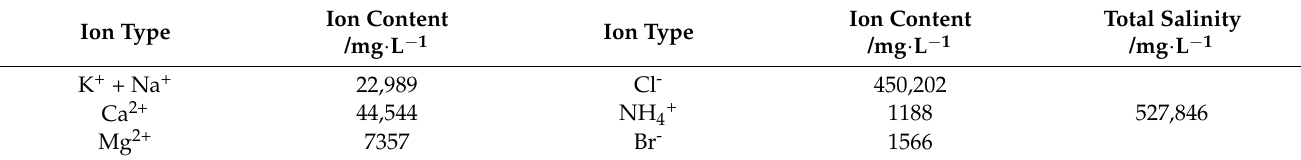
Table 1. Formation water ions.